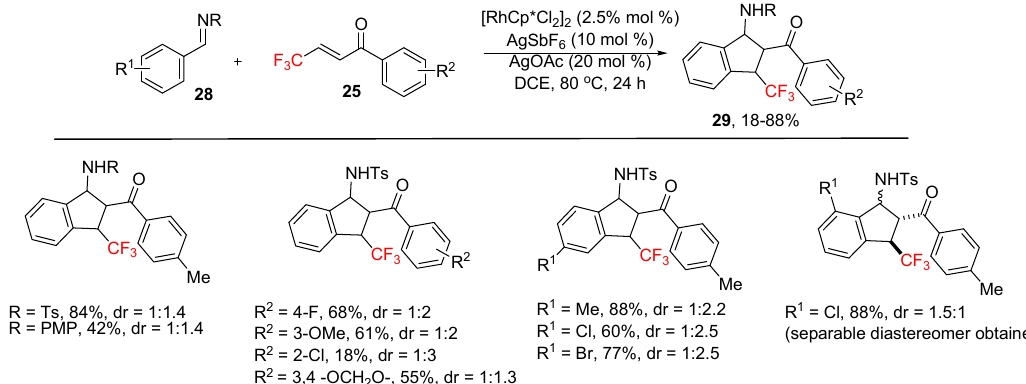
Scheme 20. Synthesis of CF 3 -aminoindanes 29 by Rh(III)-catalyzed [3+2] annulation of β -CF 3 -enones 25 with aldimines 28 .